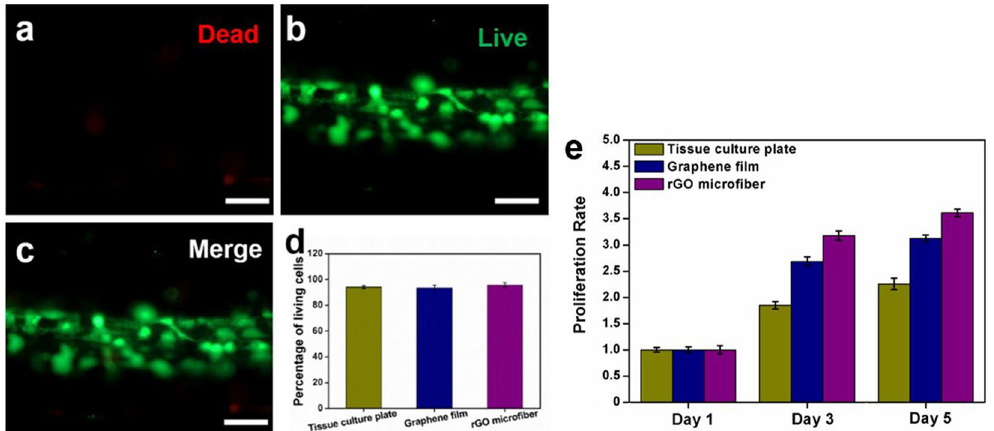
Figure 2. NSCs viability on the scaffolds. Cell viability assay of NSCs on the nanostructured rGO microfiber after 3 days of culture by the Live/Dead assay; dead cells were stained red ( a ), live cells were stained green ( b ), and ( c ) is the merged image; (Scale bar = 50 μ m) the percentage of living cells ( d ) and cells proliferation rate ( e ) on tissue culture plate, 2D graphene film and nanostructured rGO